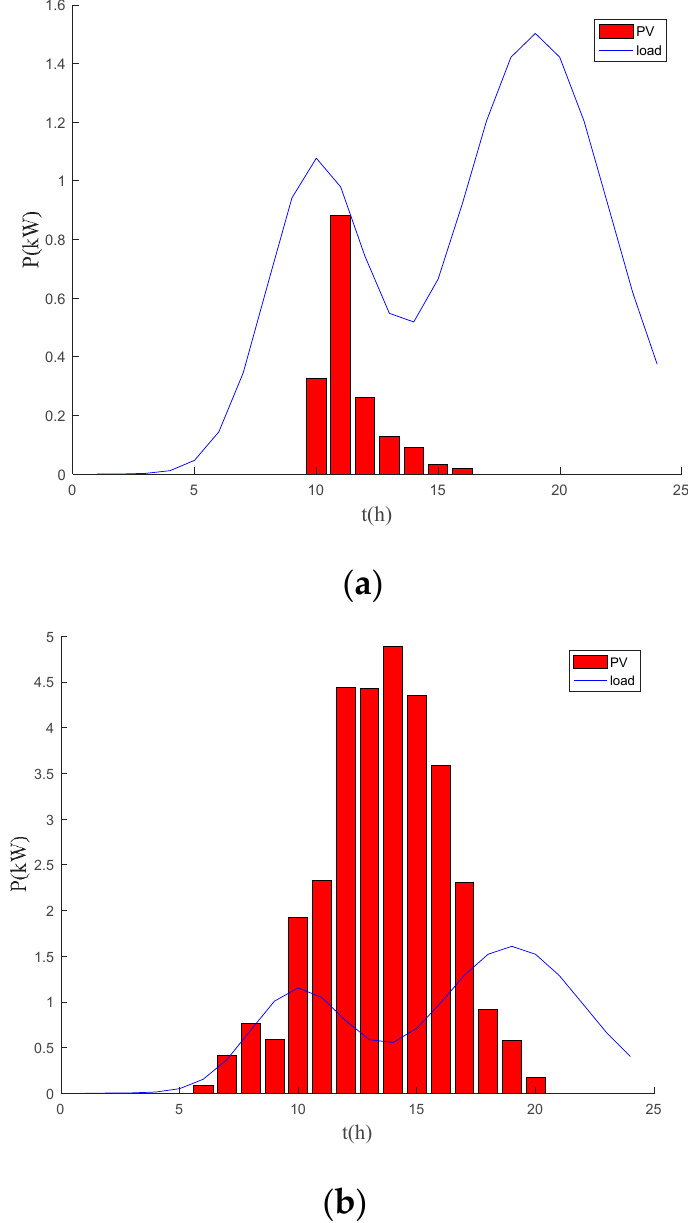
Figure 14. PV and load forecasting curves of new microgrid scenarios. ( a ) PV and load forecasting curves in winter. ( b ) PV and load forecasting curves in summer.